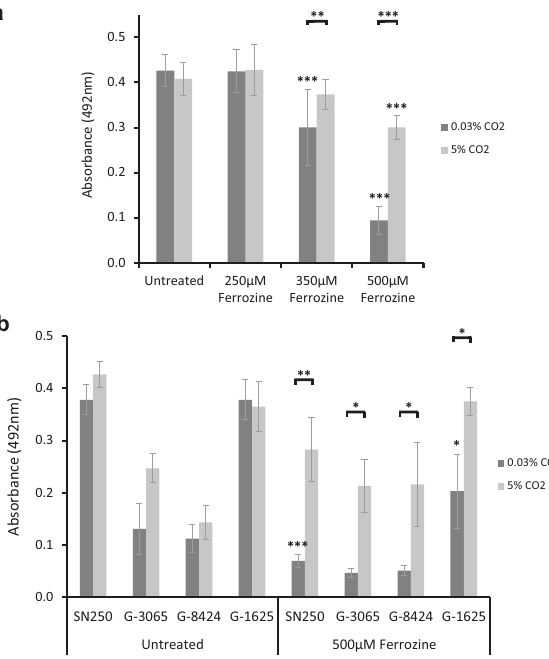
Fig. 5 The effect of high (5%) CO 2 on iron starvation in C. albicans bio fi lms. Bio fi lms were seeded and grown for 48 h in the presence of the Fe 2 + chelator Ferrozine before XTT quanti fi cation. a Iron starvation bio fi lm growth assay using the SN250 reference strain. Graph represents six biological replicates each containing technical triplicates, error bars denote standard deviation. b Iron starvation bio fi lm growth assay using clinical isolates. Graph represents three biological replicates each containing technical triplicates, error bars denote standard deviation. Two-way ANOVAs followed by Tukey tests for multiple comparisons were carried out: * p < 0.05, ** p < 0.01, *** p <